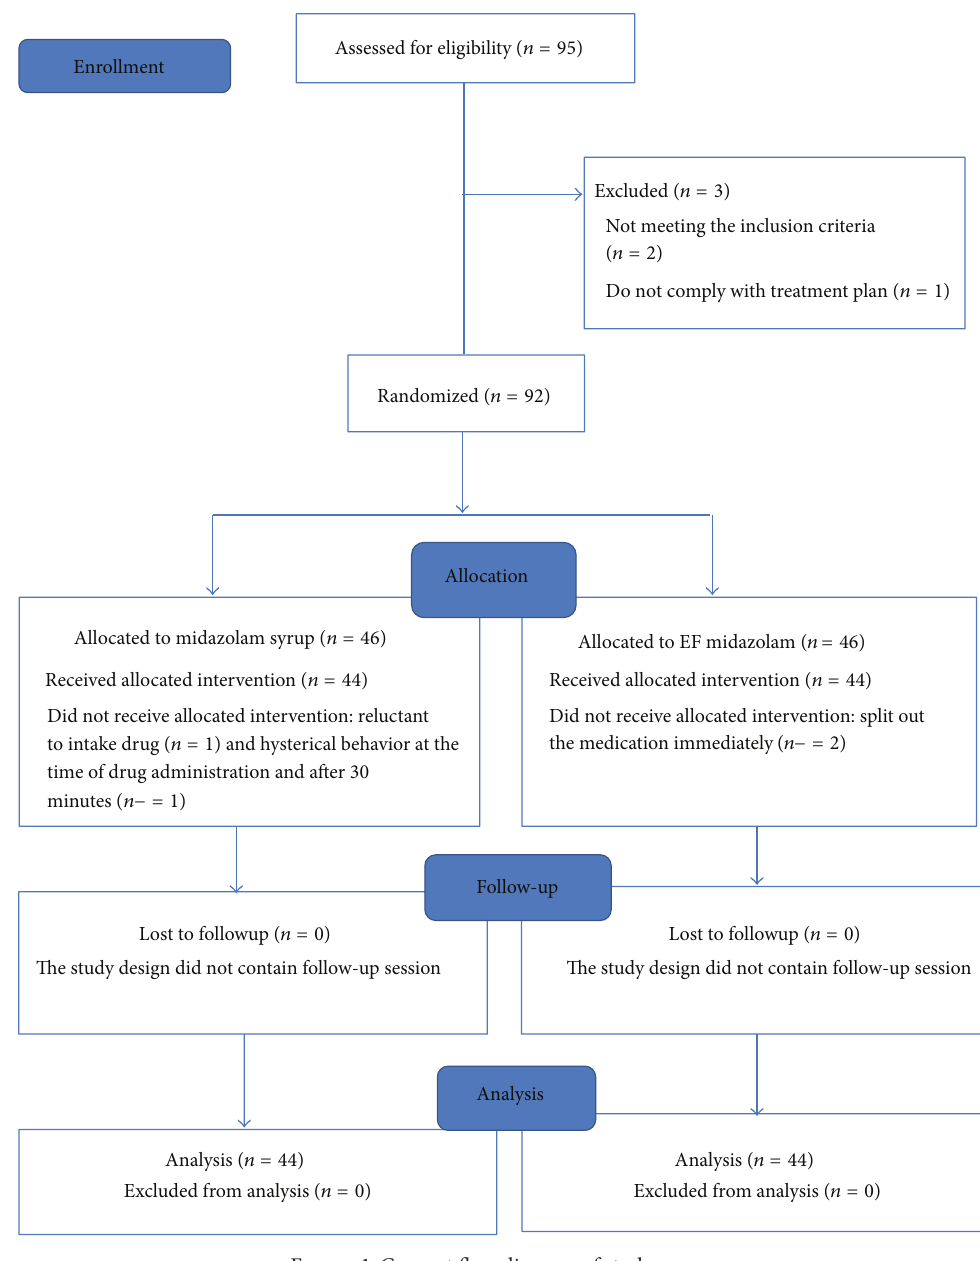
Figure 1: Consort flow diagram of study